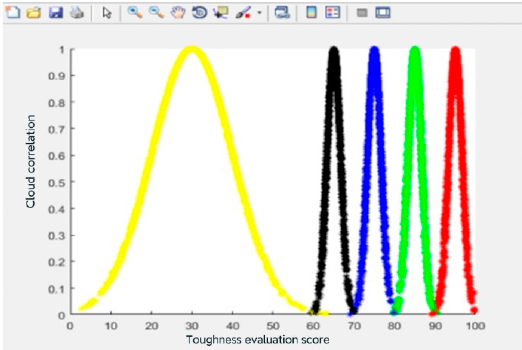
Figure 4. A C 1 index standard cloud chart.